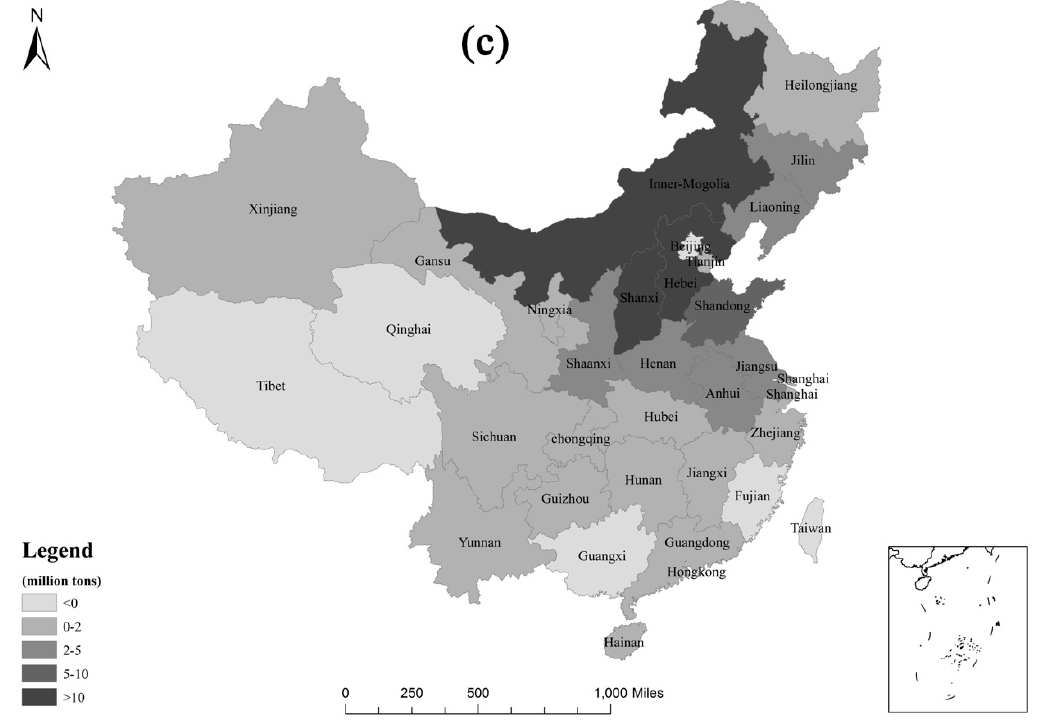
Figure 3. Net embodied carbon flowed in Beijing from other provinces in ( a ) 2002, ( b ) 2007, and ( c ) 2010 (million tons).